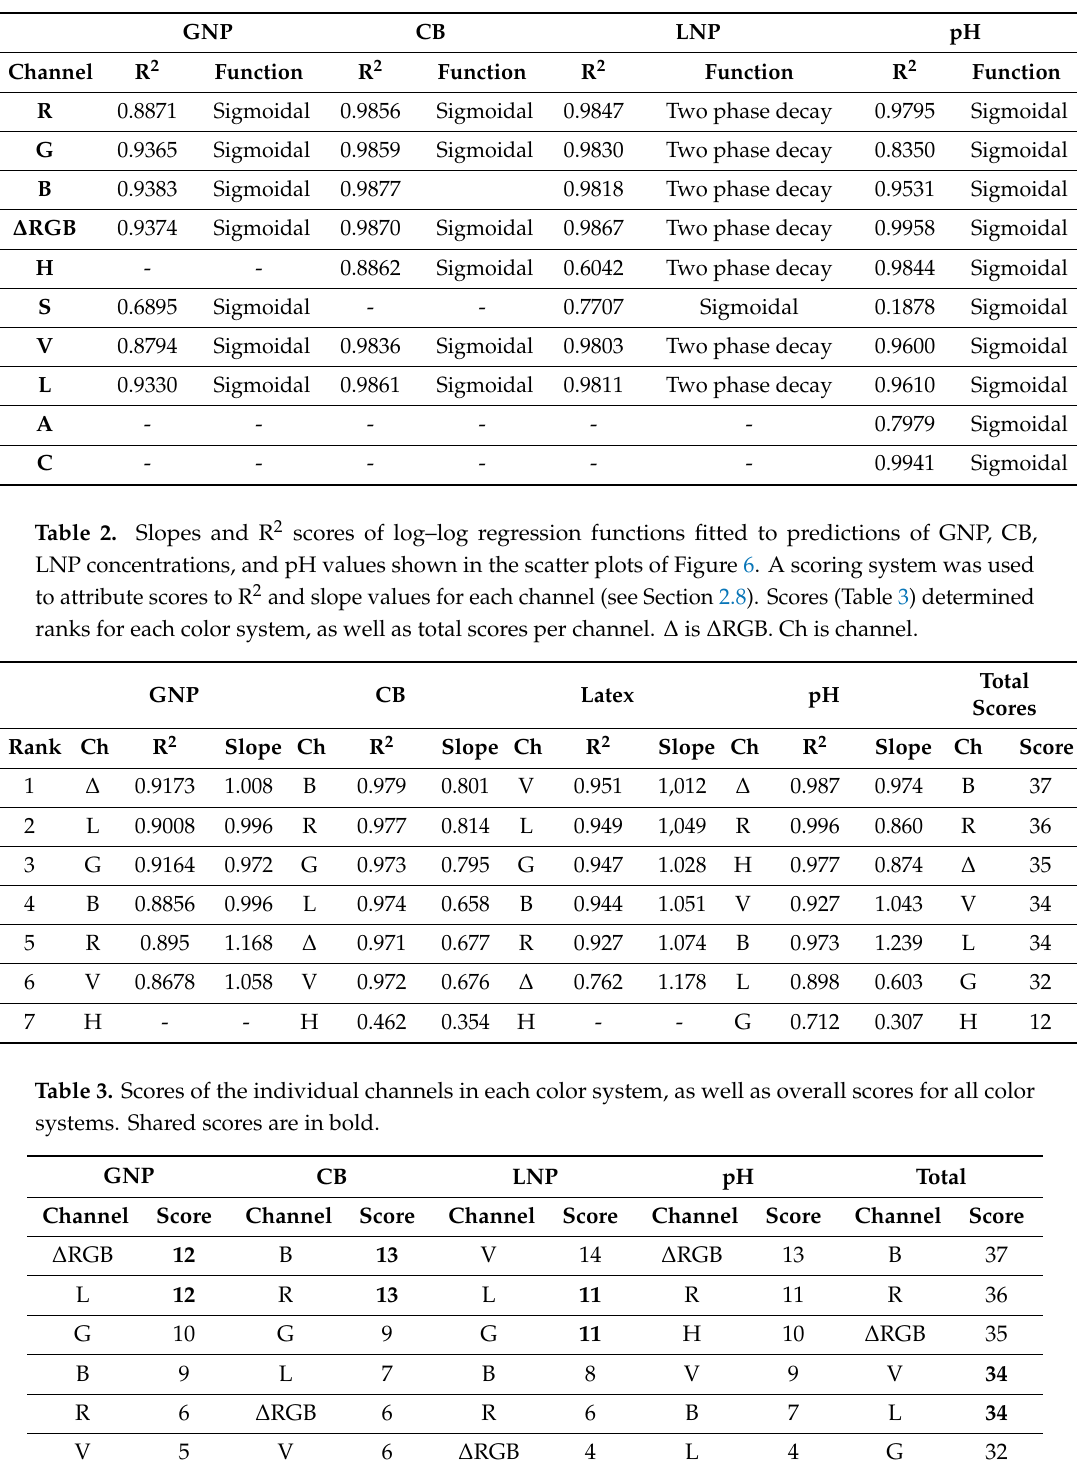
Table 1. Function types used to fit data points of the papers with varying GNP, CB, LNP concentration, and pH strips measured in various bu ff ers. R 2 values for each fit are mentioned. The fits with R 2 > 0.80 were used as calibration curves in Figure 6. C stands for the B channel of LAB which is called LAC throughout the manuscript to avoid confusion of the B channel of LAB with the B channel of RGB. Sigmoidal stands for four-parameter dose-response.